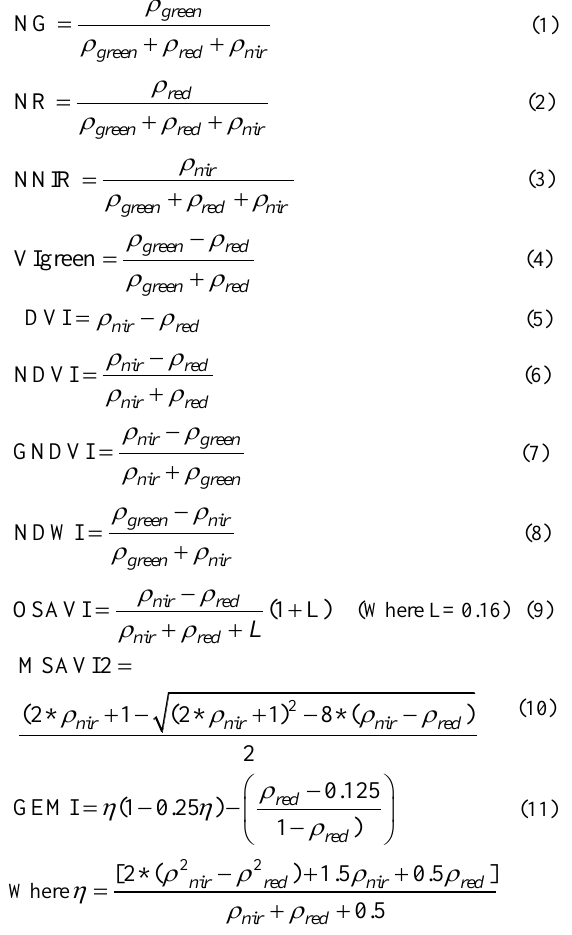
Figure 5. Generated vegetation indices images